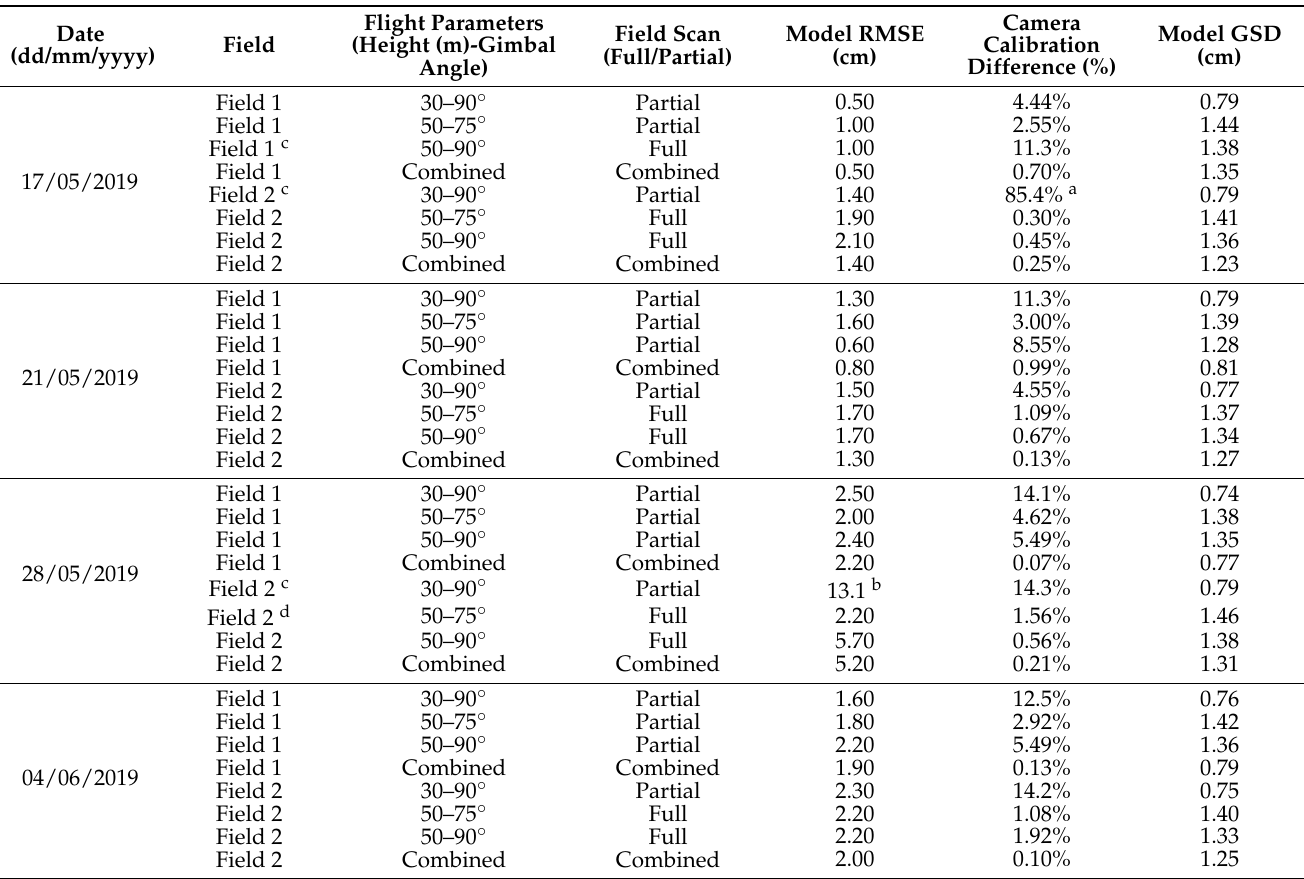
Table 4. The properties of the 32 models that were processed in this